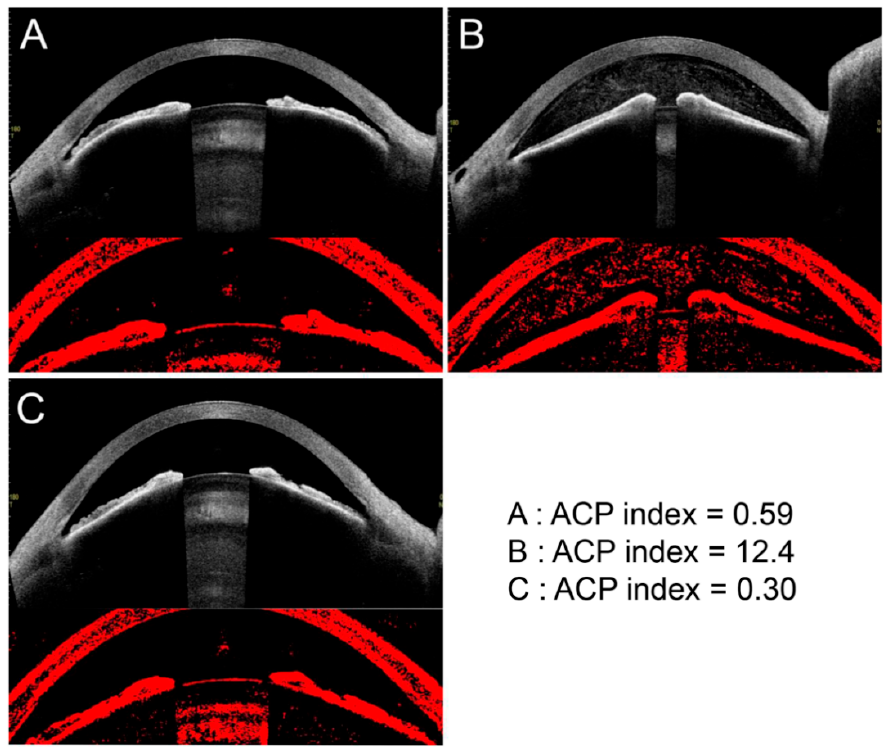
Figure 5. Representative case. Findings for an 86-year-old woman. There were no notable complications before and after LI. The ACP index increased and decreased in response to subjective changes in the anterior chamber inflammation. ACP index before LI = 0.59 ( A ), ACP index immediately after LI = 12.4 ( B ), and ACP index one week after LI = 0.30 ( C ).